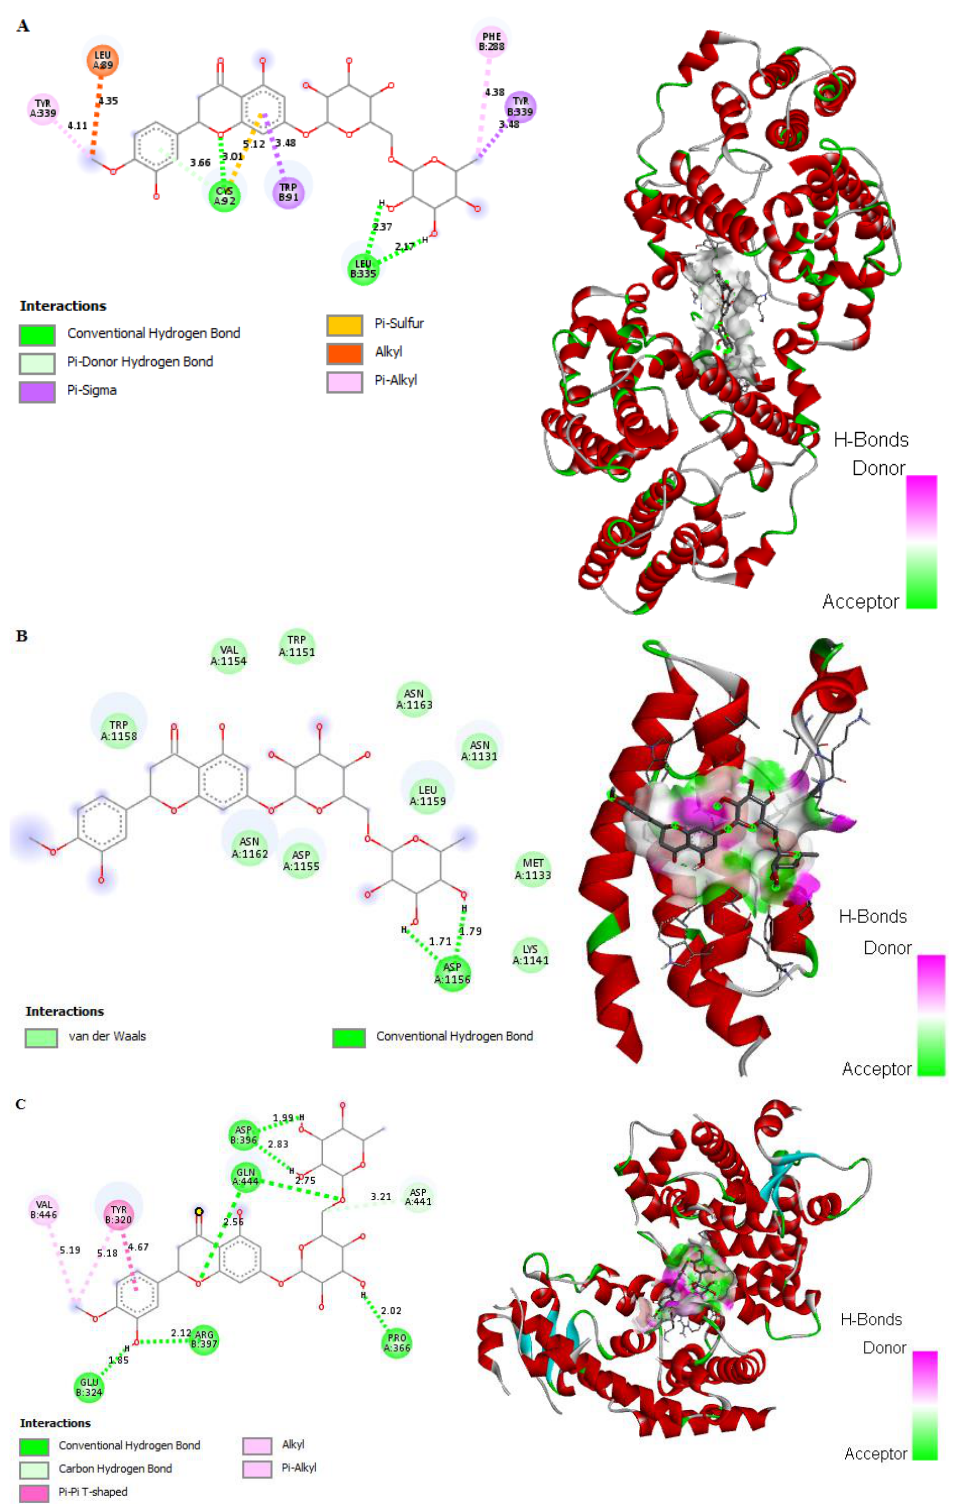
Figure 11. In silico docking and binding interactions of HSP with ( A ) DGAT1, ( B ) CEBP/ α , and ( C ) PPAR γ receptors, showing the analysis of amino-acid interactions and their length, together with the binding pocket of ligand – receptor interactions. HSP, hesperidin; DGAT1, diacylglycerol acyltransferase; CEBP/ α , CCAAT enhancer-binding protein alpha; PPAR γ , peroxisome proliferator-activated receptor gamma.